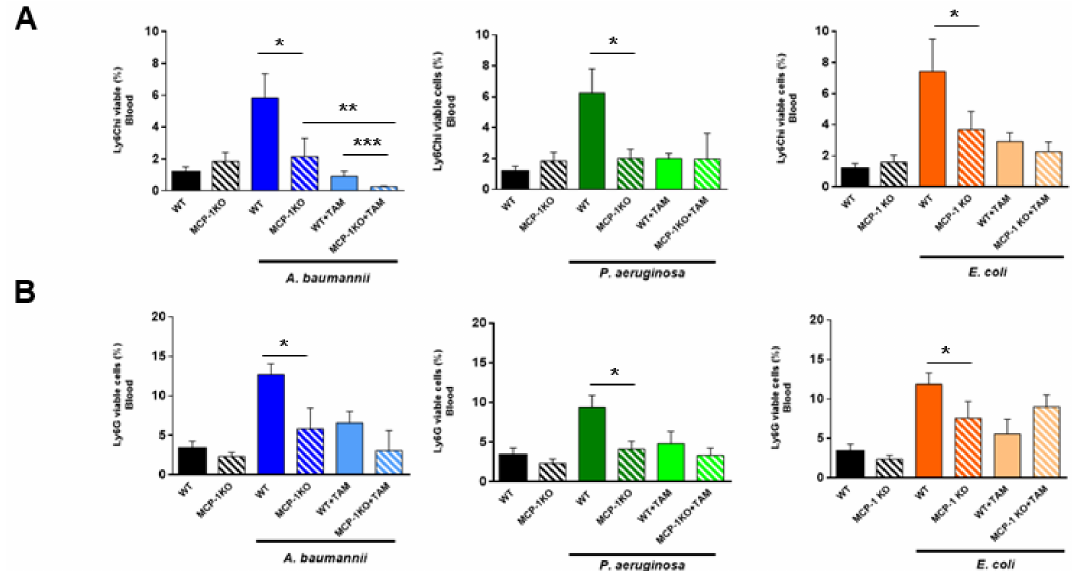
Figure 5. Tamoxifen impairs slightly, after bacterial infection in MCP-1-deficient mice, the migration of immune cells from the bone marrow to the blood through MCP-1 regulation. ( A ) WT and MCP-1 KO mice received firstly tamoxifen (80 mg/kg/d, for three days), followed by infection with a minimal lethal dose 100 of A. baumannii ATCC17978, P. aeruginosa PAO1, or E. coli ATCC25922 strains. Twenty-four hours post-infection, ( A ) inflammatory monocytes and ( B ) neutrophils were identified as CD11b+, CD11b+Ly6C hi , and CD11b+Ly6G+, respectively, by flow cytometry in the bone marrow and blood of mice. Data are representative of six mice per group and are expressed as mean ± SEM. CTL: non-infected mice. * p < 0.05: infected WT vs. infected MCP-1 KO, ** p < 0.05: infected MCP-1 KO vs. infected MCP-1 KO + TAM, *** p < 0.05: infected WT + TAM vs. infected MCP-1 KO + TAM. CTL: non-infected mice, TAM: tamoxifen, %: the percentage of inflammatory monocytes and neutrophils from total cells in